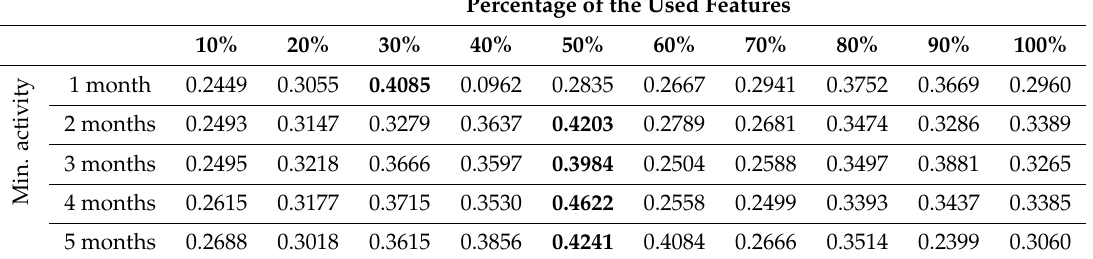
Table A9. F-score macro average for the SVM classification of three levels of the hierarchy in the manufacturing company dataset. The values which are bolded are the best results for a given minimum communication activity.